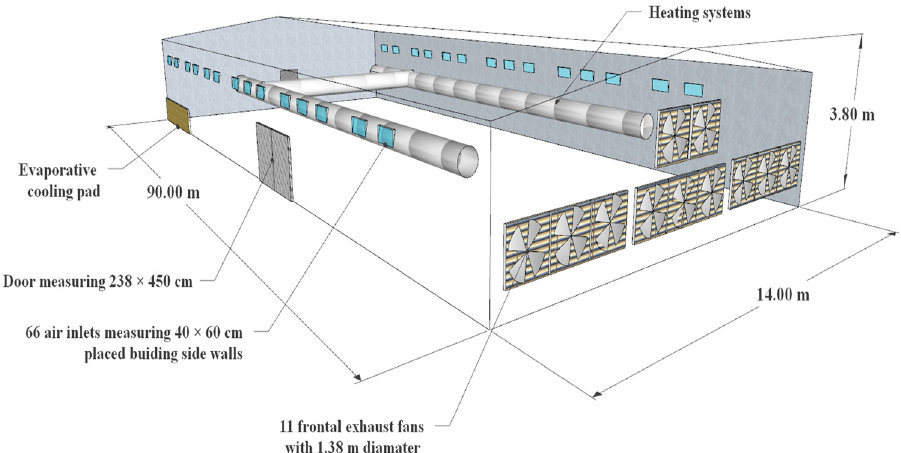
Figure 1. The dimensions of the broiler house.